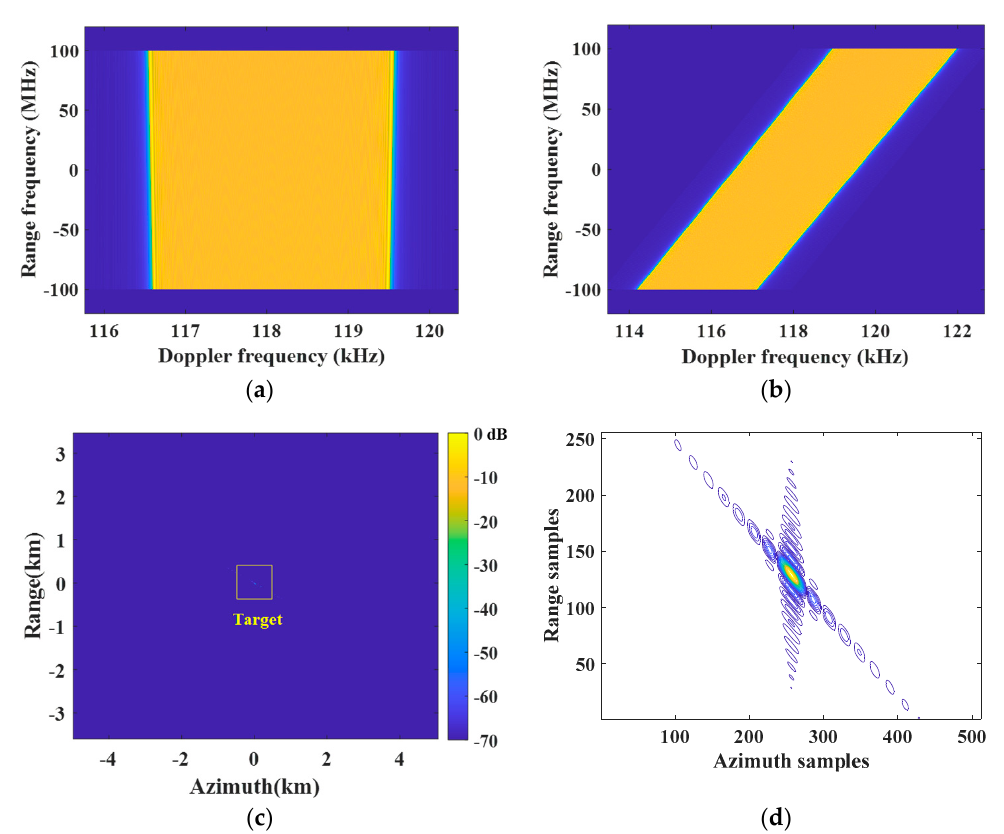
Figure 13. Simulation results of the point target in the swath center based on AHRE. ( a ) Reconstructed 2D spectrum before re-skewing; ( b ) the recovered 2D spectrum; ( c ) the focusing result; ( d ) contour plots of the point target.